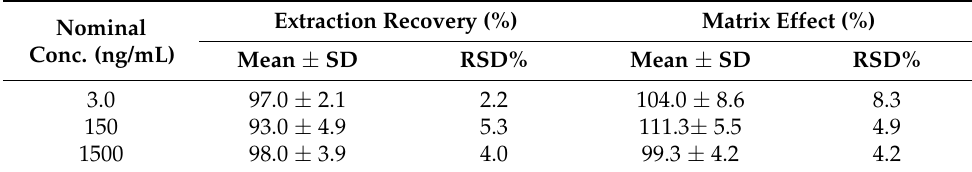
Table 5. Recovery and Matrix Effect of PF in SD rat plasma ( n = 6). Nominal Conc.